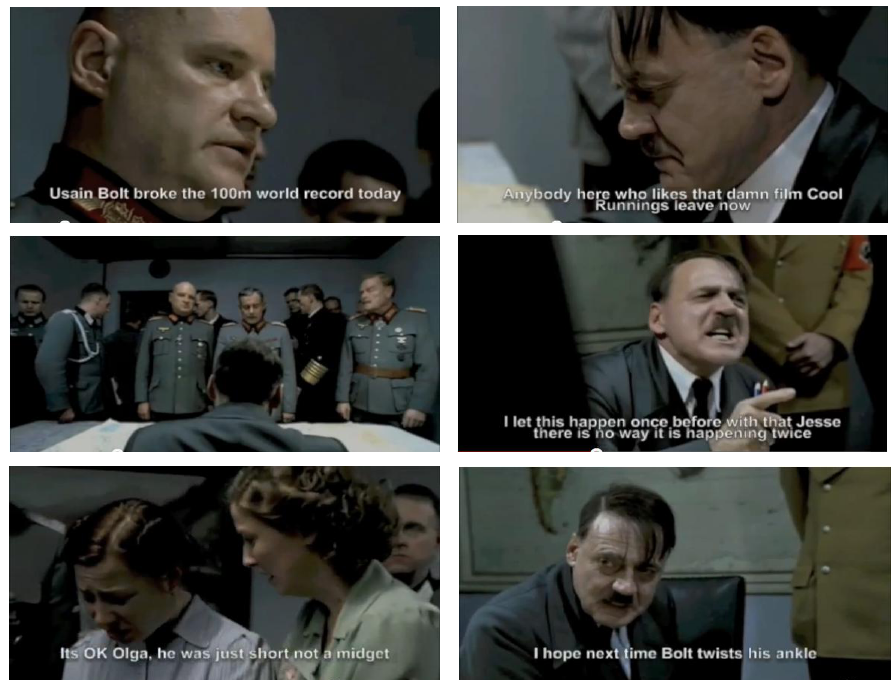
Figure 1: Video “Usain Bolt Breaks 100m World Record and Hitler Reacts,” sequence of events in the Hitler meme: delivering the news, departure from the room (request and exit), Hitler's outburst, the woman crying outside, Hitler’s dismay (sequence left to right, top to bottom). Screenshots taken on September 15,